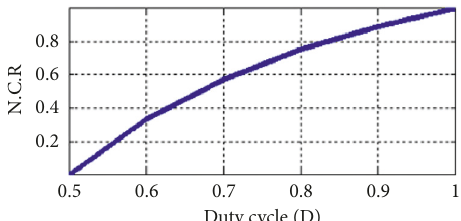
Figure 7: Normalized current ripple (NCR) by considering